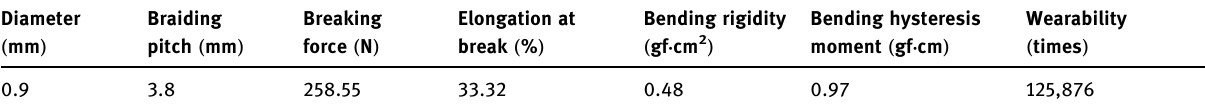
Table 1: Characteristics of braided harness cord Diameter ( mm )